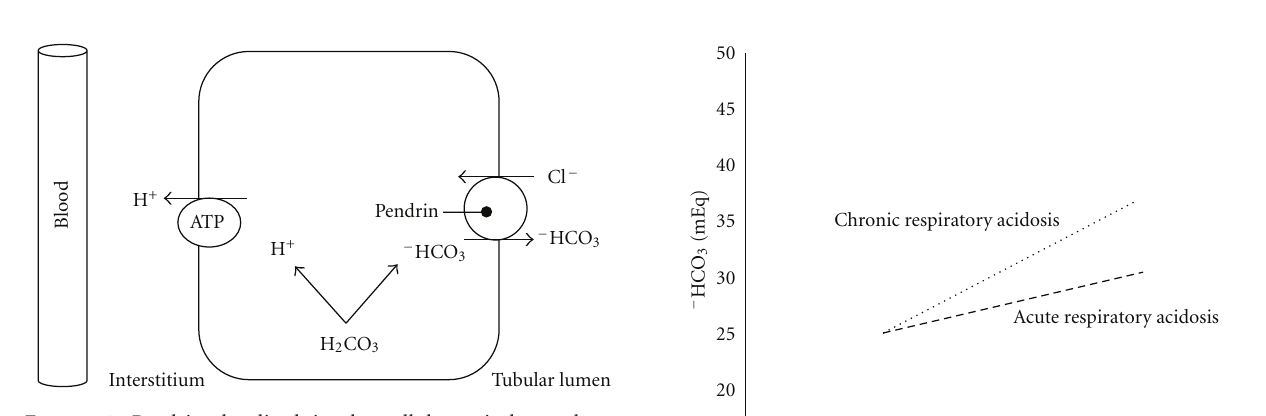
Figure 4: Pendrin, localized in the cellular apical membrane of cortical collecting ducts and connecting tubules, acts as a Cl − / − HCO 3 exchanger regulating the acid-base status and chloride homeostasis.